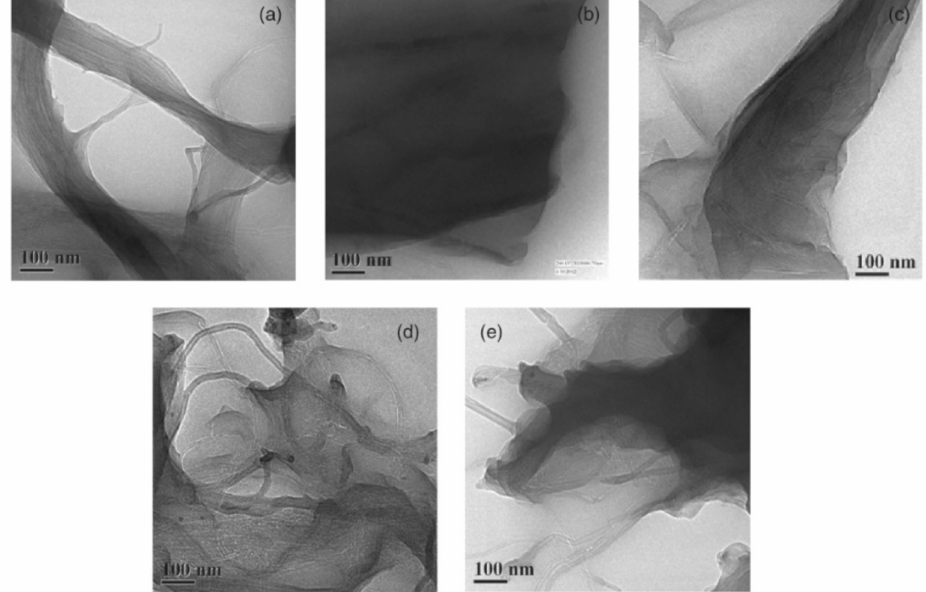
Figure 6. TEM images of ( a ) MWCNT (0.375 wt%)/silicone rubber (VMQ), ( b ) graphene (0.375 wt%)/VMQ, ( c ) MWCNT–graphene (0.375 wt%)/VMQ, ( d ) MWCNT–graphene (0.75 wt%)/VMQ, and ( e ) MWCNT–graphene (1.5 wt%)/VMQ [49]. Reproduced with